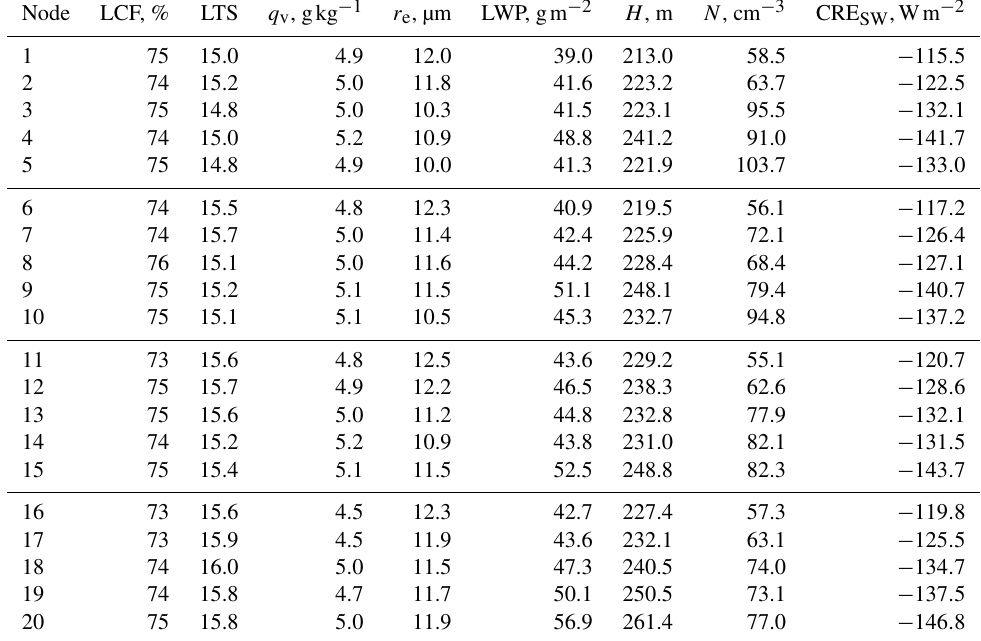
Table 2. Summary statistics for SOM node meteorological and cloud properties. We tabulate median values of the frequency distributions of r e , N , CRE SW (see Fig. 7), LWP, and H as well as those of meteorological variables LCF, LTS, and q v . Distributions are calculated over the oceanic area shown in Figs. 3, 5, and